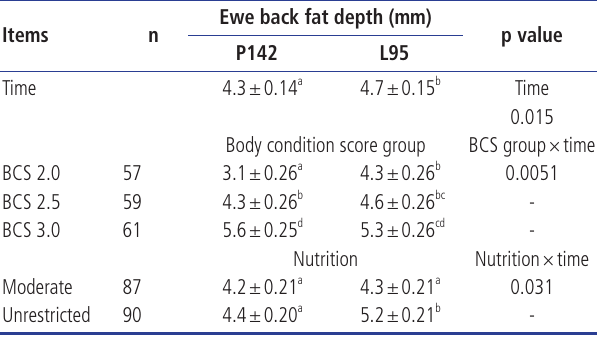
Table 3. Effect of ewe body condition score group (2.0 vs 2.5 vs 3.0) and nutritional treatment in very late pregnancy and lactation (Moderate vs Unrestricted) on ewe back-fat depth (mm; mean±SEM) at P142 and